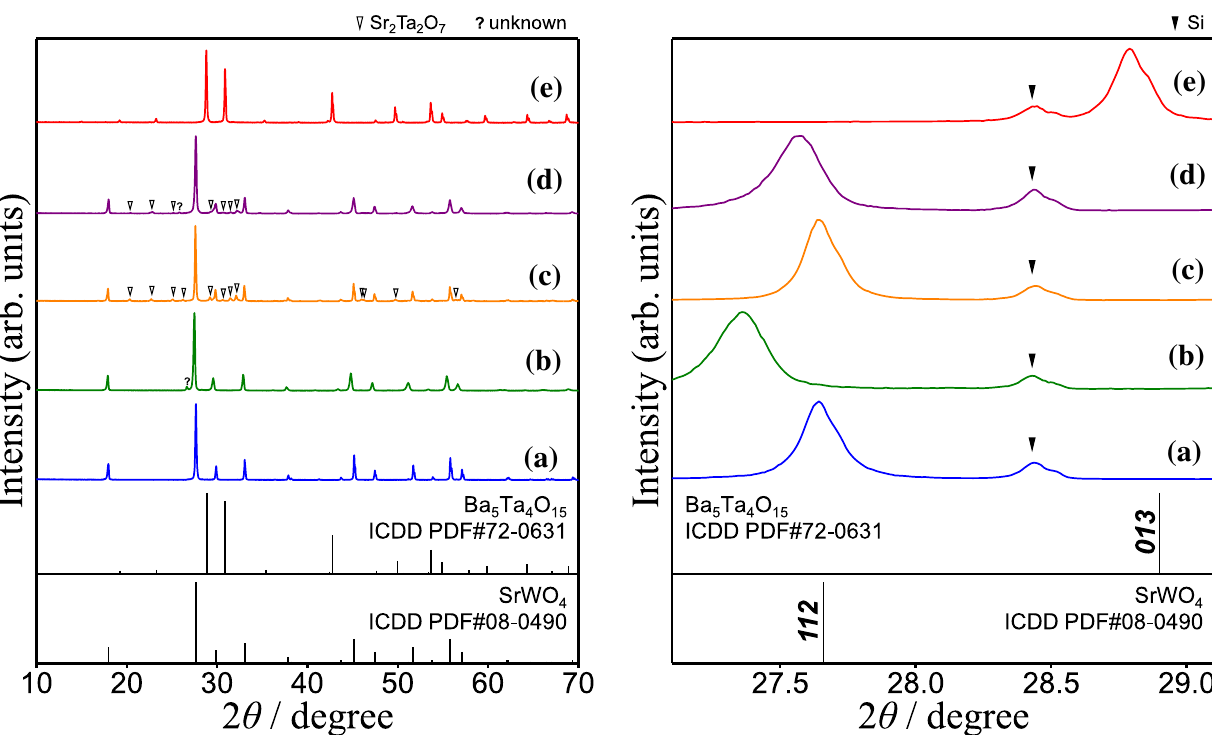
Fig. 1 XRD patterns of Sr 1 - x Ba x W 1 - y Ta y O 4 - (1/2) y : ( a ) x , y = 0,0; ( b ) x , y = 0.25,0; ( c ) x , y = 0,0.25; ( d ) x , y = 0.125,0.125; and ( e ) Ba 5 Ta 4 O 15 crystals grown by a solid-state reaction and KCl flux method Table 1 Unit cell parameters of tetragonal Sr 1 - x Ba x W 1 - y Ta y O 4 -